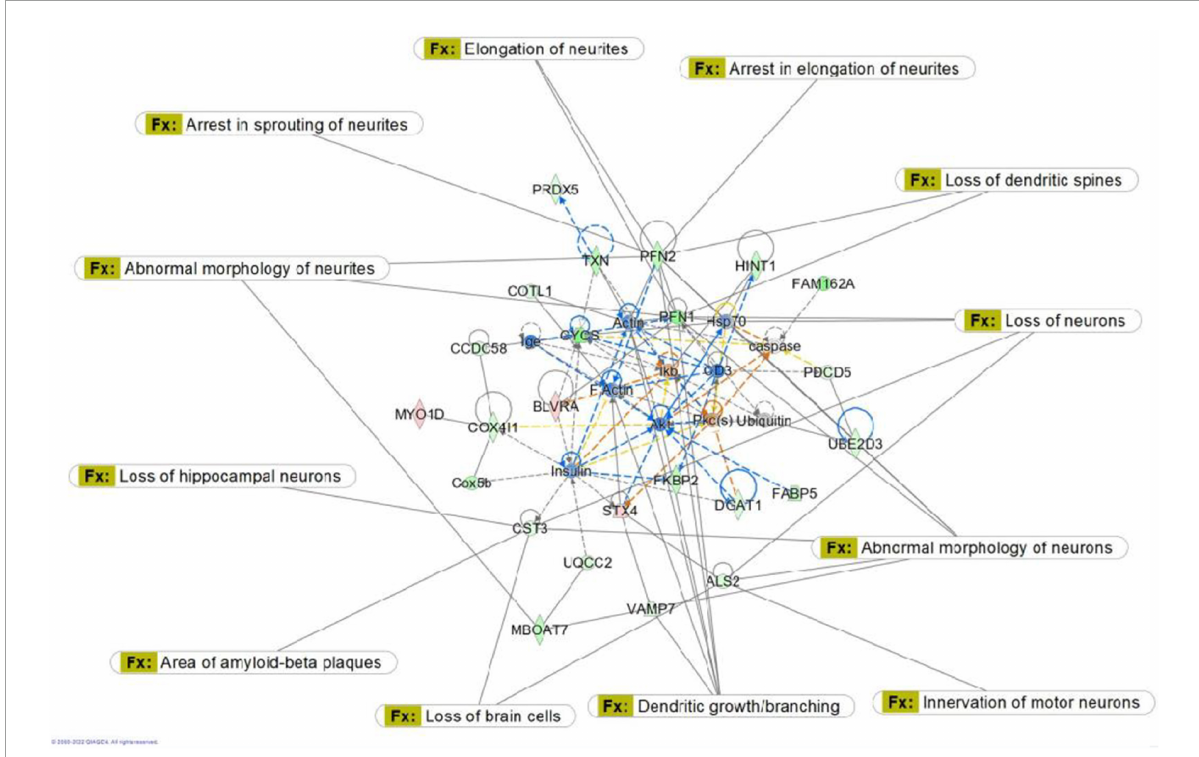
FIGURE8 Graphic representation of mouse hippocampus protein network 1, identified by Ingenuity Pathway Analysis (IPA) as being affected by sham irradiation compared to galactic cosmic rays (GCR) irradiation. Functions associated with the network include free-radical scavenging, cellular assembly and organization, and cellular function and maintenance. The network is overlayed with the disease and function tool to display the 14 key molecules involved with cell morphology. Reproduced with a license obtained from